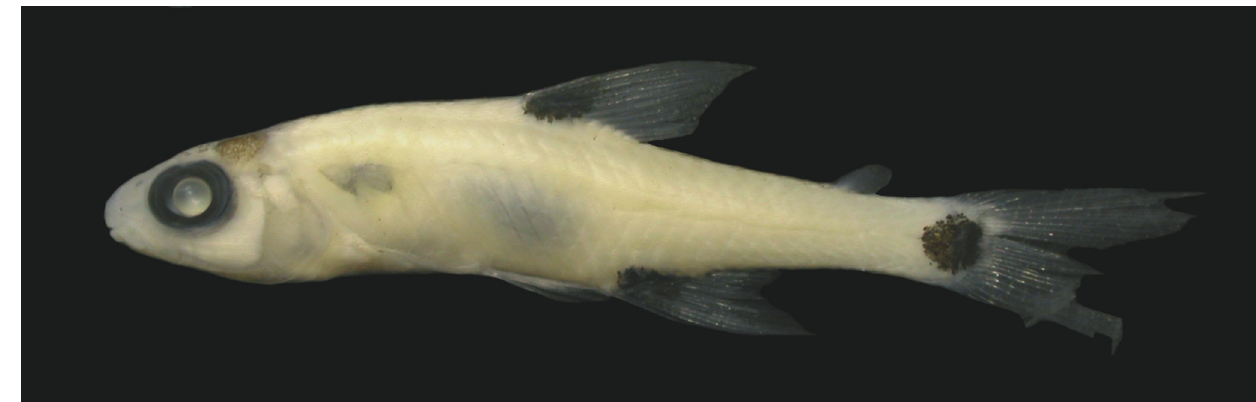
Fig. 1. Holotype of Amazonspinther dalmata , new species, MCP 38623, undetermined sex, 19.63 mm